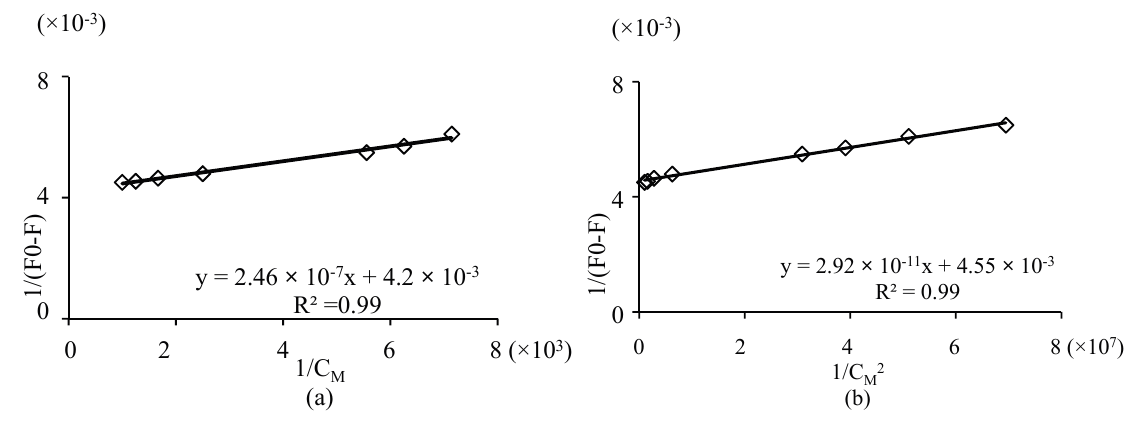
) plotted against: ( a ) 1/C 0